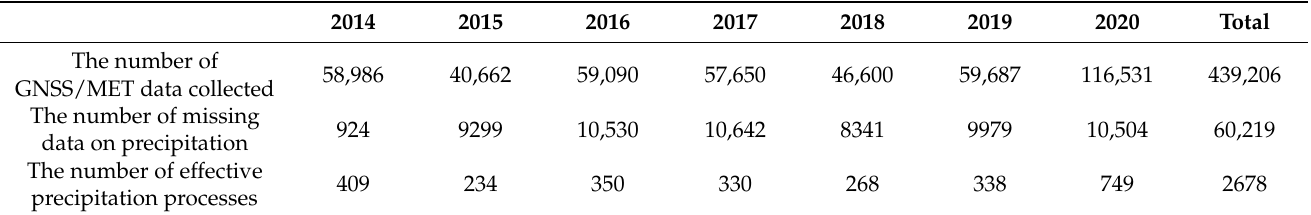
Table 1. LPM area data collection statistics over six years, including the total amount of GNSS/MET data every year, the number of missing precipitation measurements and the number of effective precipitation